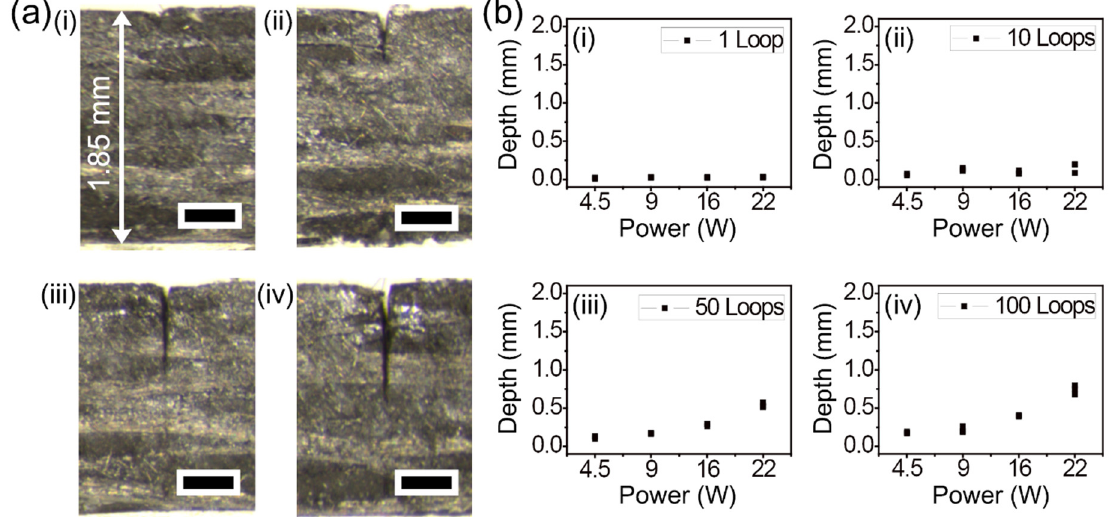
Figure 7. Picosecond laser cutting of the thermoplastic CFRP with lateral single-pass processing. ( a ) Stereoscopic microscope cross-section images by a power of 22 W and (i) 1 loop, (ii) 10 loops, (iii) 50 loops, and (iv) 100 loops, respectively. Each scale bar = 400 µm. ( b ) Systematic investigation of cutting depths by power variation and the number of loops variation with (i) 1, (ii) 10, (iii) 50, and (iv) 100. The common experimental condition was a scan speed of 0.5 m/s.